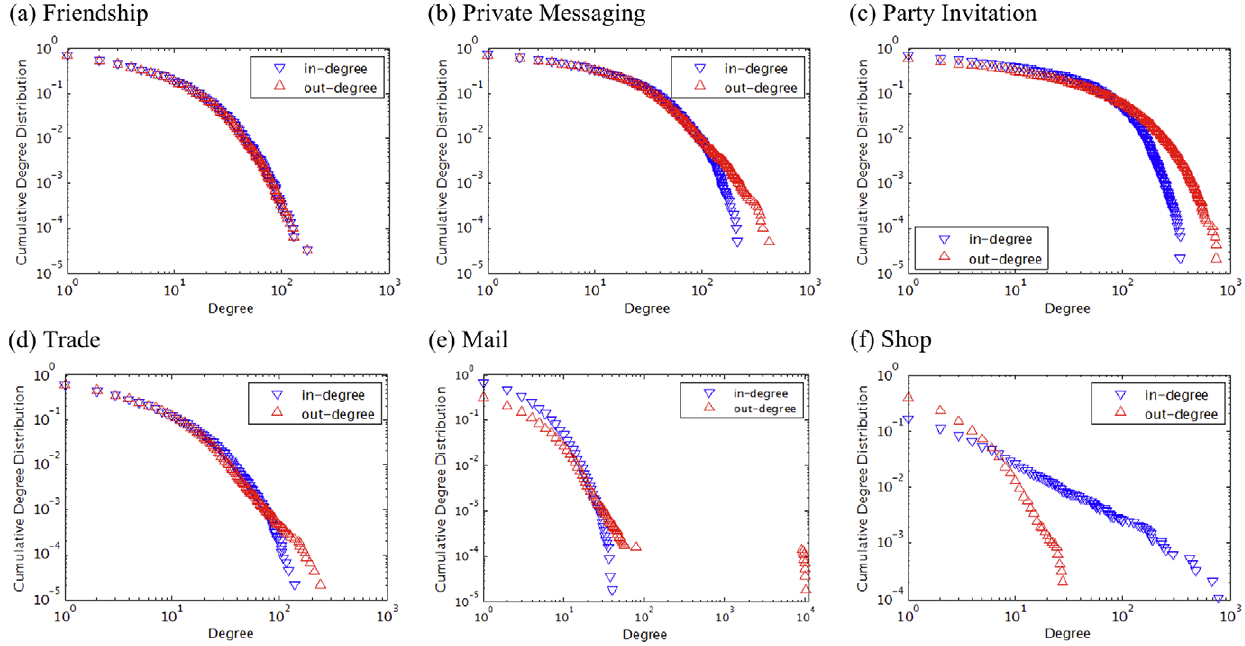
Figure 4. The in- and out-degree distributions in AION are most dissimilar in the case of the Mail and Shop networks. In Shop, the highly skewed in-degree distribution is caused by the existence of œmagnate merchants In Mail, the outliers in the out-degree nodes specify a special class of high-volume senders such as in-game managers.